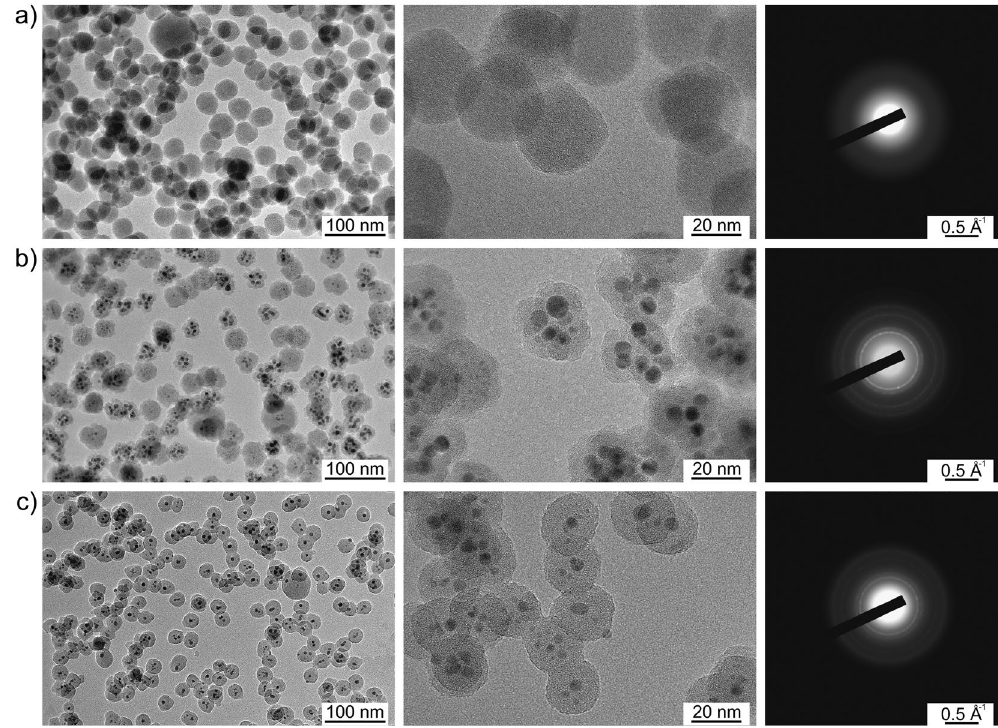
Figure 2. TEM images with lower (left column) and higher (middle column) magnification of the NPs prepared by GAS: ( a ) from the Ar/HMDSO mixture with graphite target and ( b ) from the Ar/HMDSO mixture with Ag target (in both cases the HMDSO flow rate is 0.45 sccm); ( c ) from the Ar/HMDSO/O 2 mixture with Ag target (0.15% HMDSO, 3.8% O 2 , Ar flow rate 105sccm, pressure 190 Pa). The right column shows the corresponding diffraction patterns.